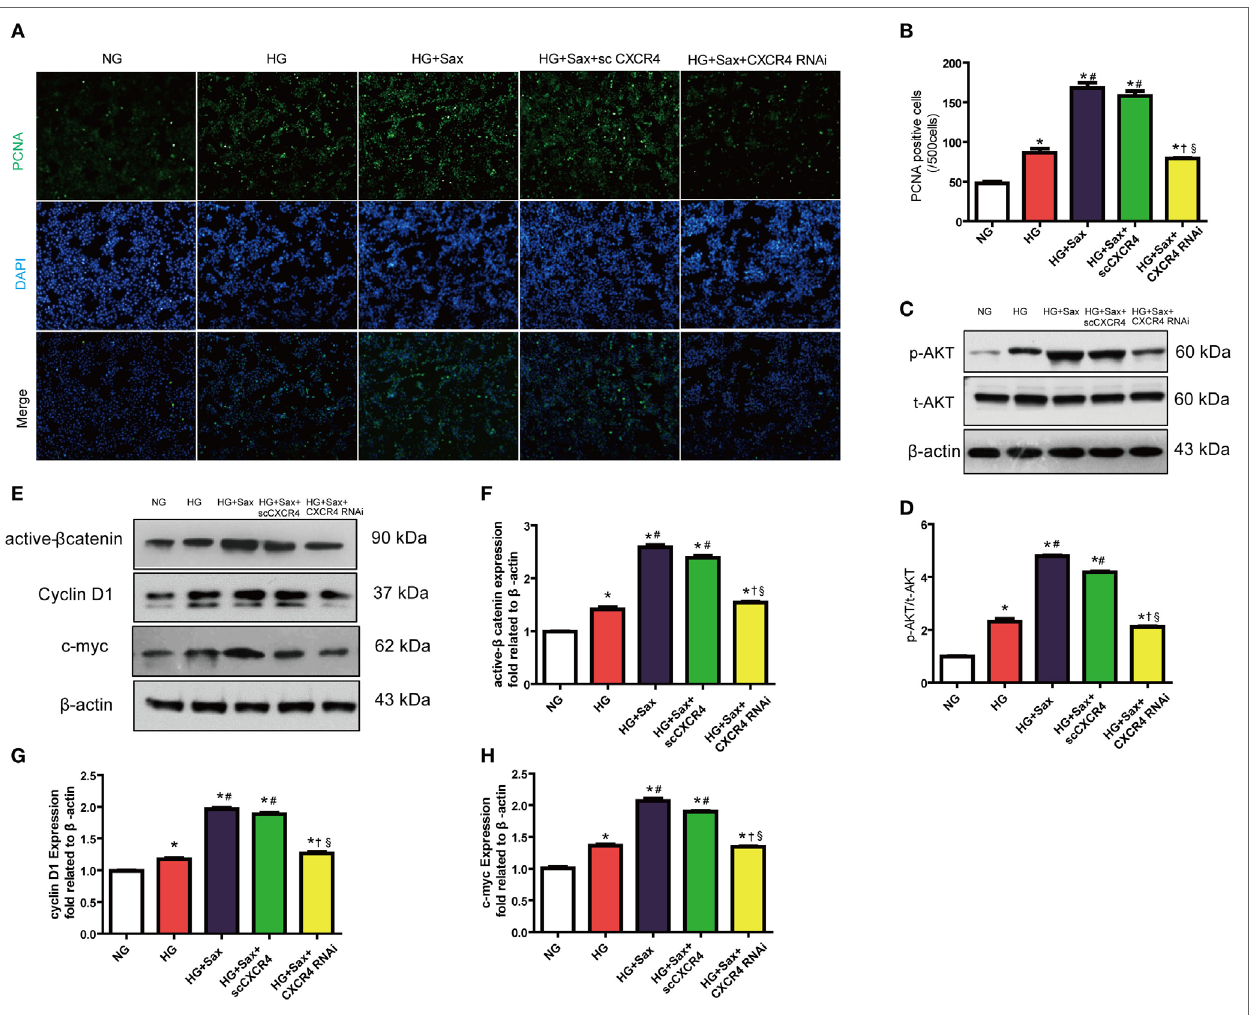
FigUre 5 | Saxagliptin-induced β -cell proliferation depends on the stromal cell-derived factor-1 α /CXCR4 pathway in INS cells. Representative images showing PCNA-positive cells in cultured INS-1cells from different conditions (a) and the positive cell number analysis (b) . Western blot analysis for protein expression of p-AKT in pancreas of rats (c) . Densitometric analysis of t-AKT protein expression relative to t-AKT is shown (D) . Western blot analysis for indicated protein expression from different conditions (e) . Densitometric analyses of indicated protein expression relative to β -actin levels are shown (F–h) . Data were reported as mean ± SEM ( n = 3). * p < 0.05 compared with the NG group, # p < 0.05 compared with HG group, † p < 0.05 compared with HG + Sax group; § p < 0.05 compared with HG + with HG + Sax + scCXCR4 group. NG, normal glucose; HG, high glucose; Sax, saxagliptin; scCXCR4, scramble CXCR4 RNAi; p-AKT, phosphorylation of Akt; t-AKT, total